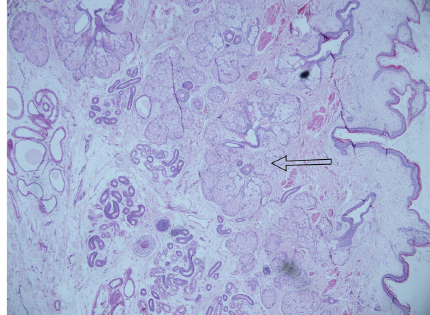
Figure 2: Microscopic examination showed mature squamous epithelium with formation of a granular cell layer with underlying sebaceous glands (arrow), filling the cyst with laminated keratin (hematoxylin and eosin (H&E), 100x